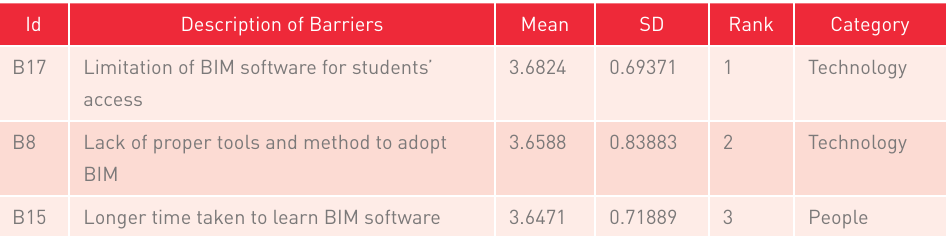
Mean value of barriers for BIM adoption in civil engineering